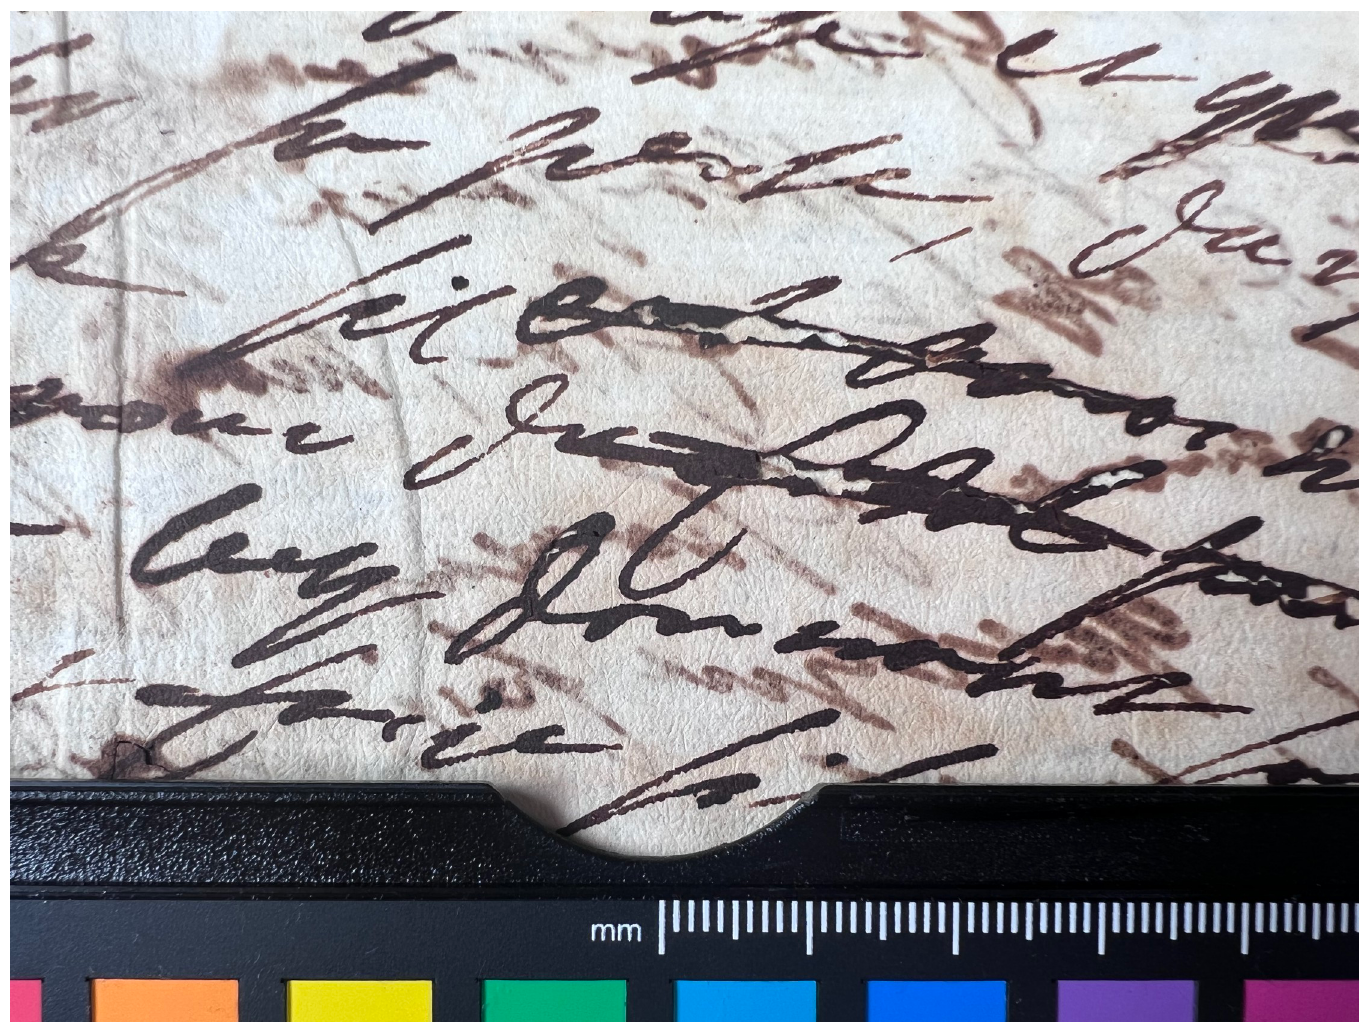
Fig 15. Ink thickness 4. Visual estimation of ink thickness 4, exemplified through a document from volume K 400 of the Azzolino collection.